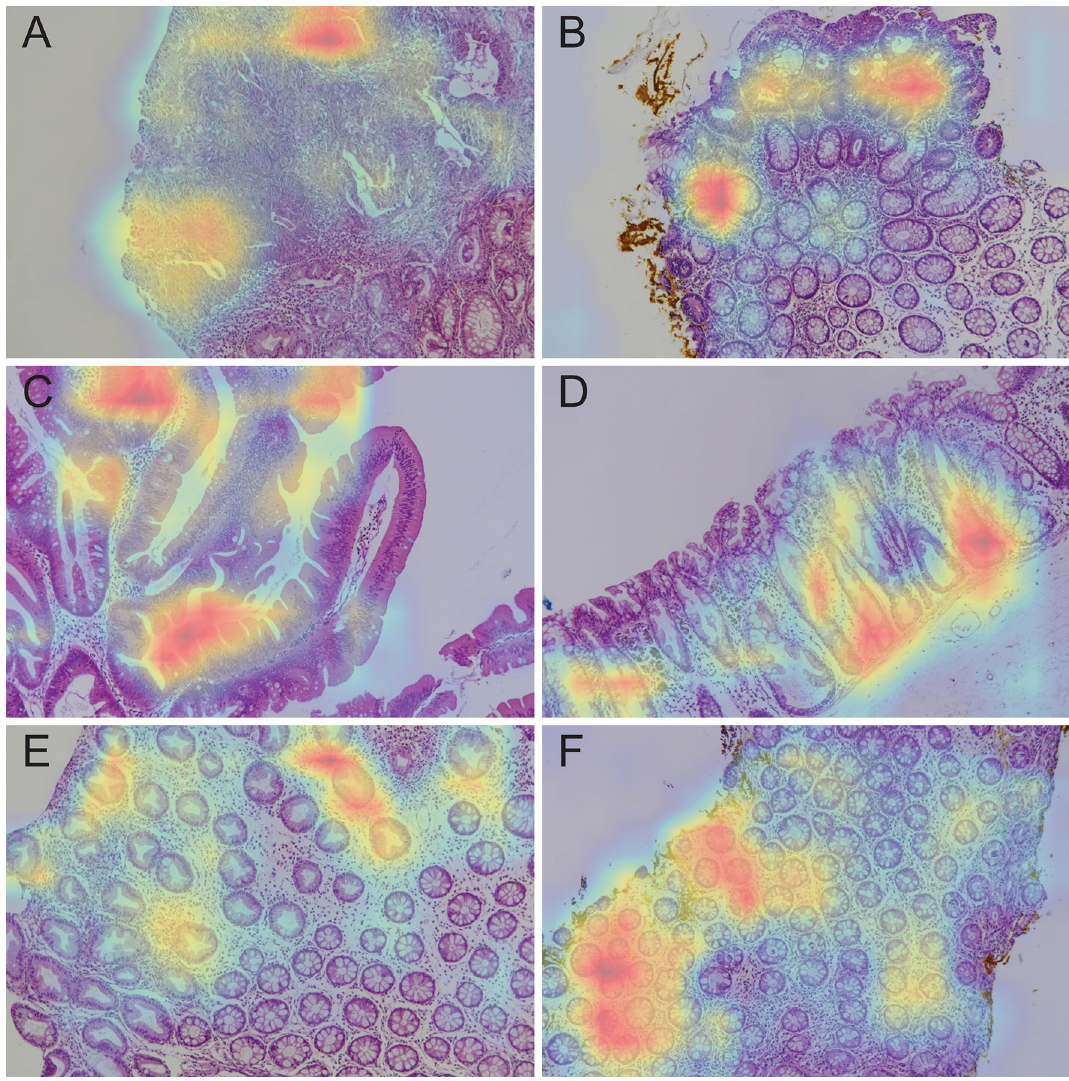
Figure 3. Representative images of Grad-CAM for each class: ( A ) adenocarcinoma, ( B ) tubular adenoma, ( C ) traditional serrated adenoma, ( D ) sessile serrated adenoma, ( E ) hyperplastic polyp, and ( F ) non-specific